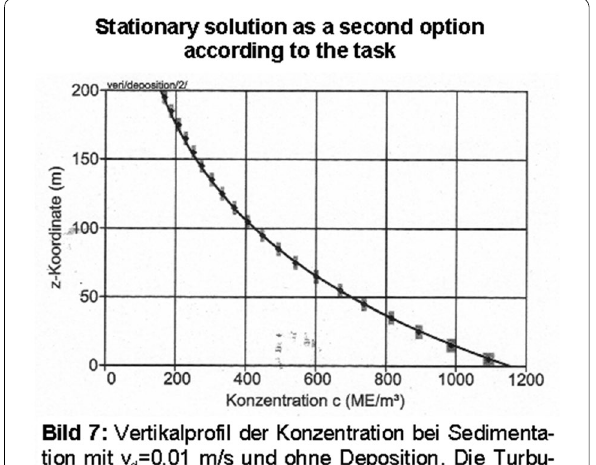
Fig. 4 Pollutant particles are speculatively redistributed by the authors of